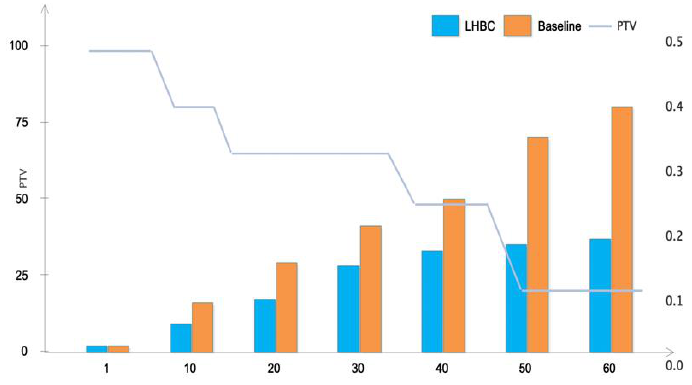
Figure 5. LLBF block verification performance evaluation.